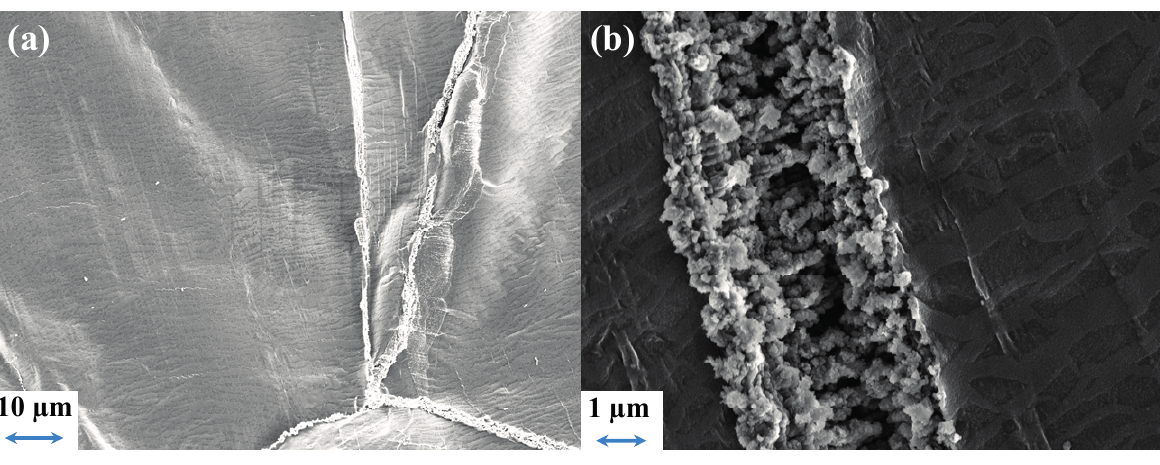
Figure 10. Evolution of the impedance spectra at 21 °C of Freudenberg FS2190 cells during cycling at 40 °C and 0.1 mA·cm − 2 ( a ) PYR